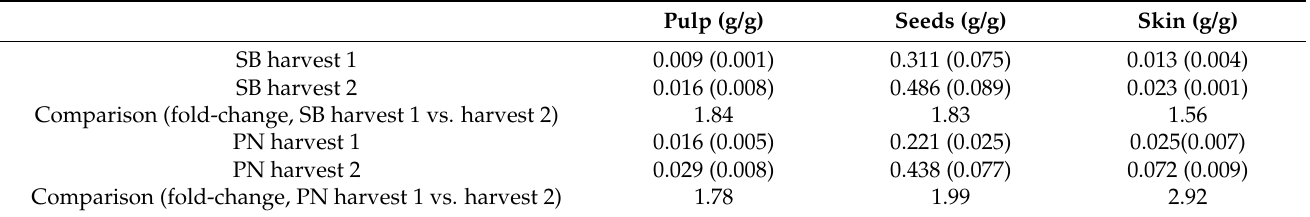
Table 3. Saturated and unsaturated fatty acids detected and identified in Sauvignon blanc (SB) and Pinot noir (PN) juices, extracts and tissues. Standard deviations are shown within